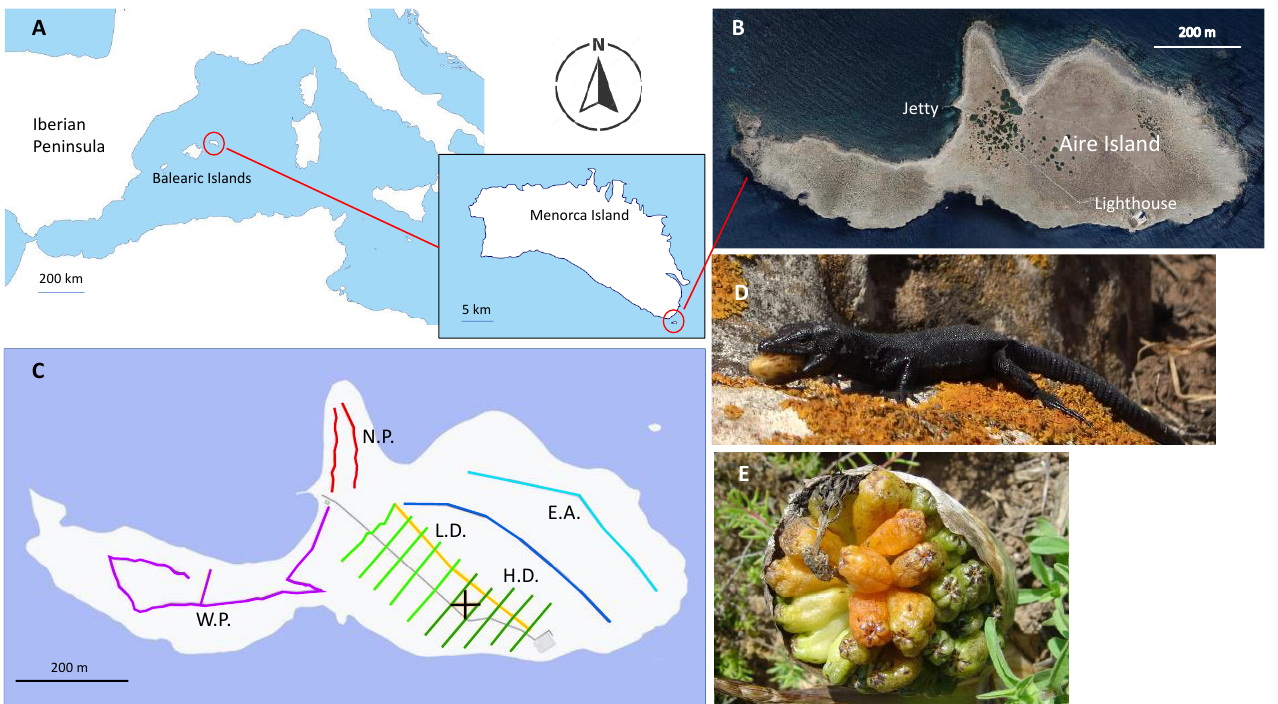
Figure 1. ( A ) Location of Aire Island off the southeastern coast of Menorca (Balearic Islands, Spain). ( B ) Orthophoto of Aire Island. Situation of the jetty and the lighthouse at either end of a main track (grey). ( C ) Location of lizard and plant line transects at different areas of Aire Island, Northern Peninsula (N.P., four line transects, red lines), Eastern Area (E.A., 12 line transects: six from inner east, dark blue lines, and six from coastal east, light blue lines), Western Peninsula (W.P., 12 line transects, purple lines), Low-density area (L.D., 10 line transects, light green lines, made separately to the east and to the west of the main track), and high-density area (H.D., 10 line transects, dark green lines, also separately to the east and to the west of the main track). In high-density areas, the black cross shows the position of the four line transects of 25 m of plant density sampled from 1999 (see more details in the text and Table A2). Additionally, every year we estimated lizard densities in low-density and high-density areas with line transects covering the central part of the island and ending at the enclosure of the lighthouse (yellow line). ( D ) An adult male of Podarcis lilfordi handling a ripe fruit of Helicodiceros muscivorus . ( E ) Top of an infrutescence of Helicodiceros muscivorus with ripe (orange) and unripe (green) fruits.